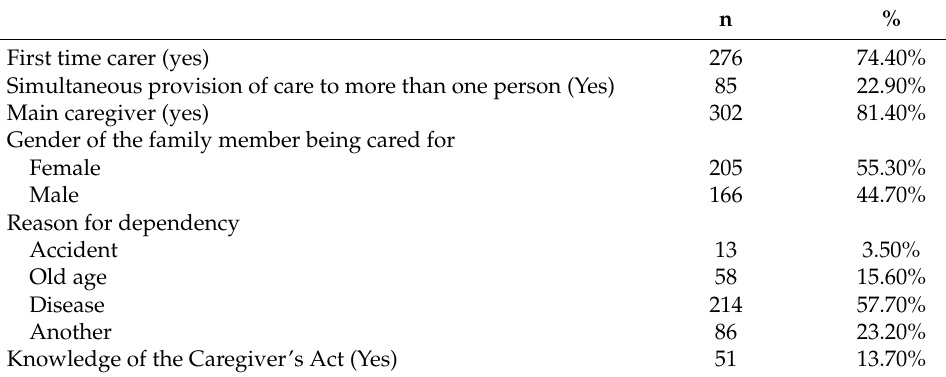
Table 2. Characterization of the carer role.